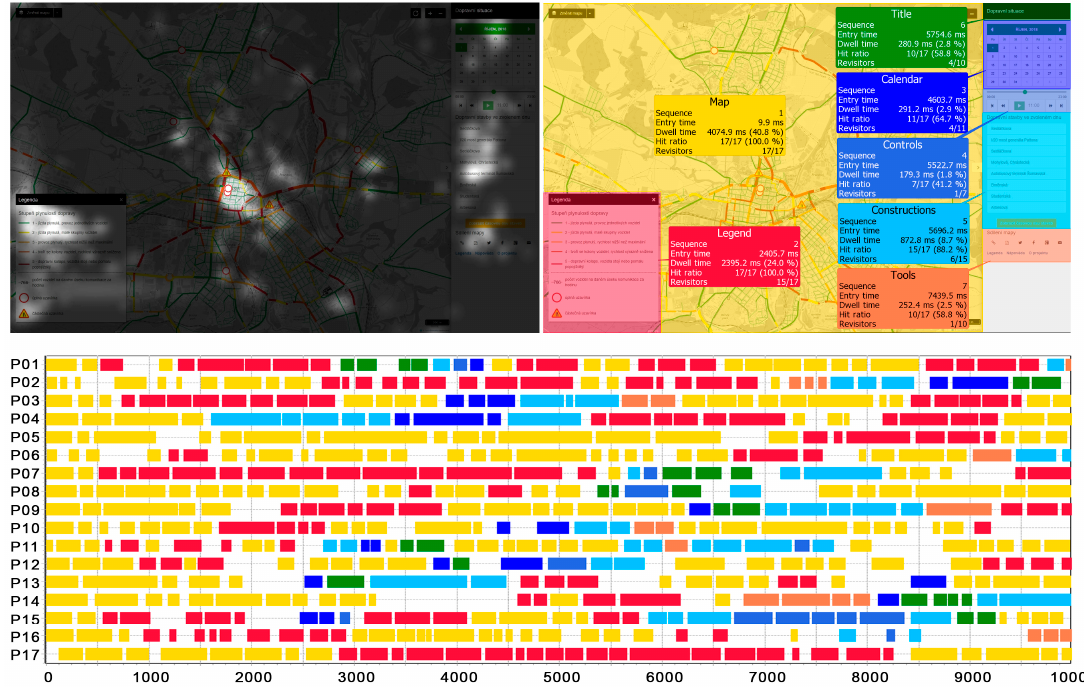
Figure 7. Analysis of recorded data for static stimulus of Pilsen map. Focus map ( upper left ), key performance indicators ( upper right ), and sequence chart ( bottom ).